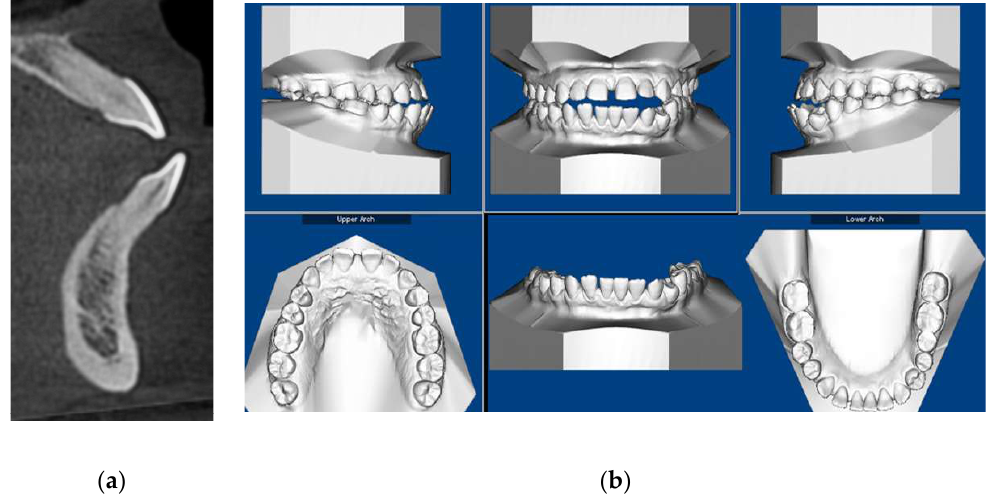
Figure 2. ( a ) Cone-beam computed tomographs (CBCT)-driven sagittal screen of lower incisor showing its severe proclination with no bone appears on most of the labial surface of the root; ( b ) Initial digital models.